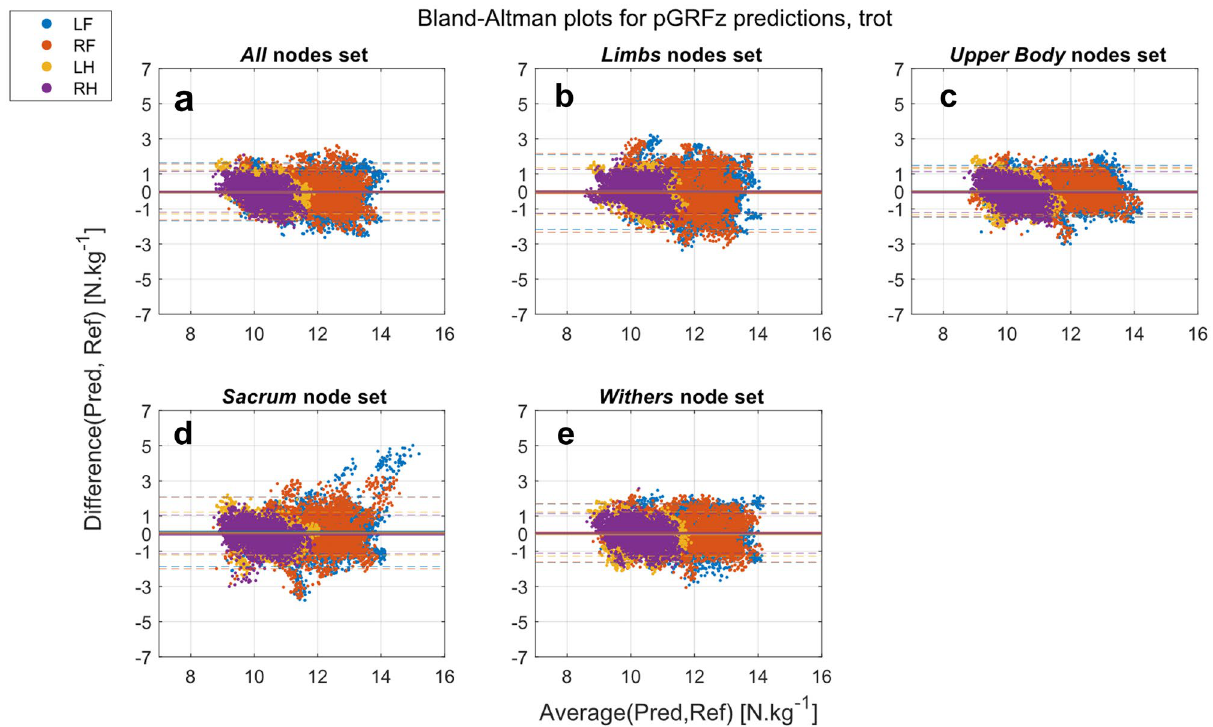
Figure 6. Bland–Altman plots of the predicted pGRFz by different nodes sets at trot (Pred) against the reference values extracted from the TiF data (Ref): ( a ) All (head, withers, sacrum, and limbs nodes); ( b ) Limbs (limb nodes); ( c ) Upper-body (head, withers and sacrum nodes); ( d ) Sacrum (sacrum node); ( e ) Withers (withers node). LF left front, RF right front, LH left hind, RH right